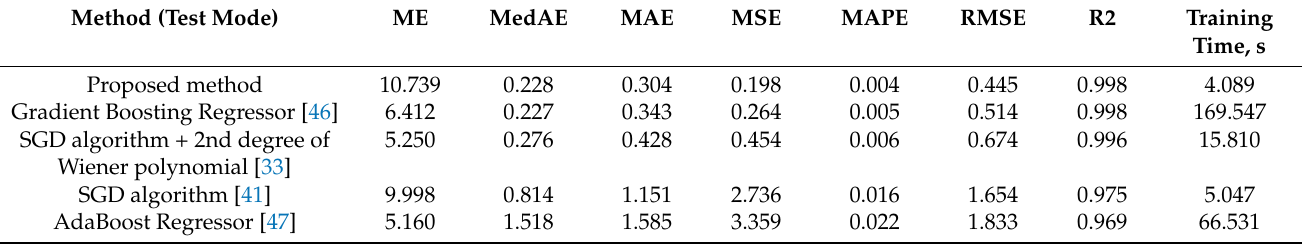
Table 6. Performance indicators for all investigated